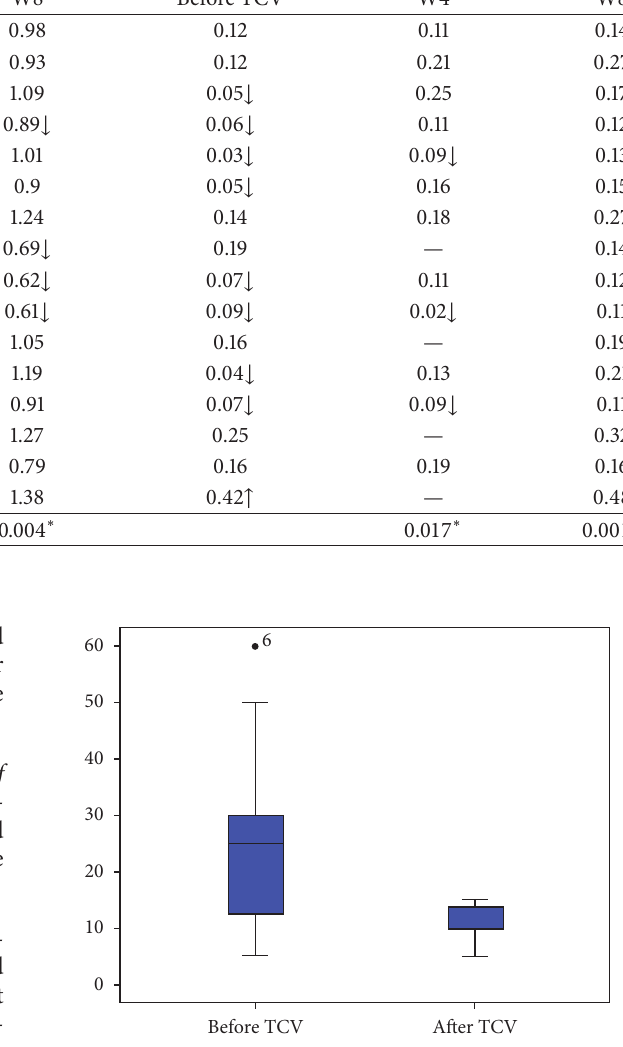
Figure 1: The changes of routine GC